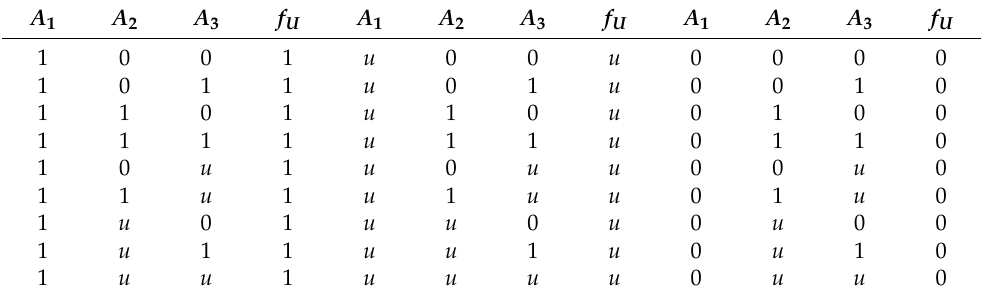
Table 11. Kleene relations for three variables.